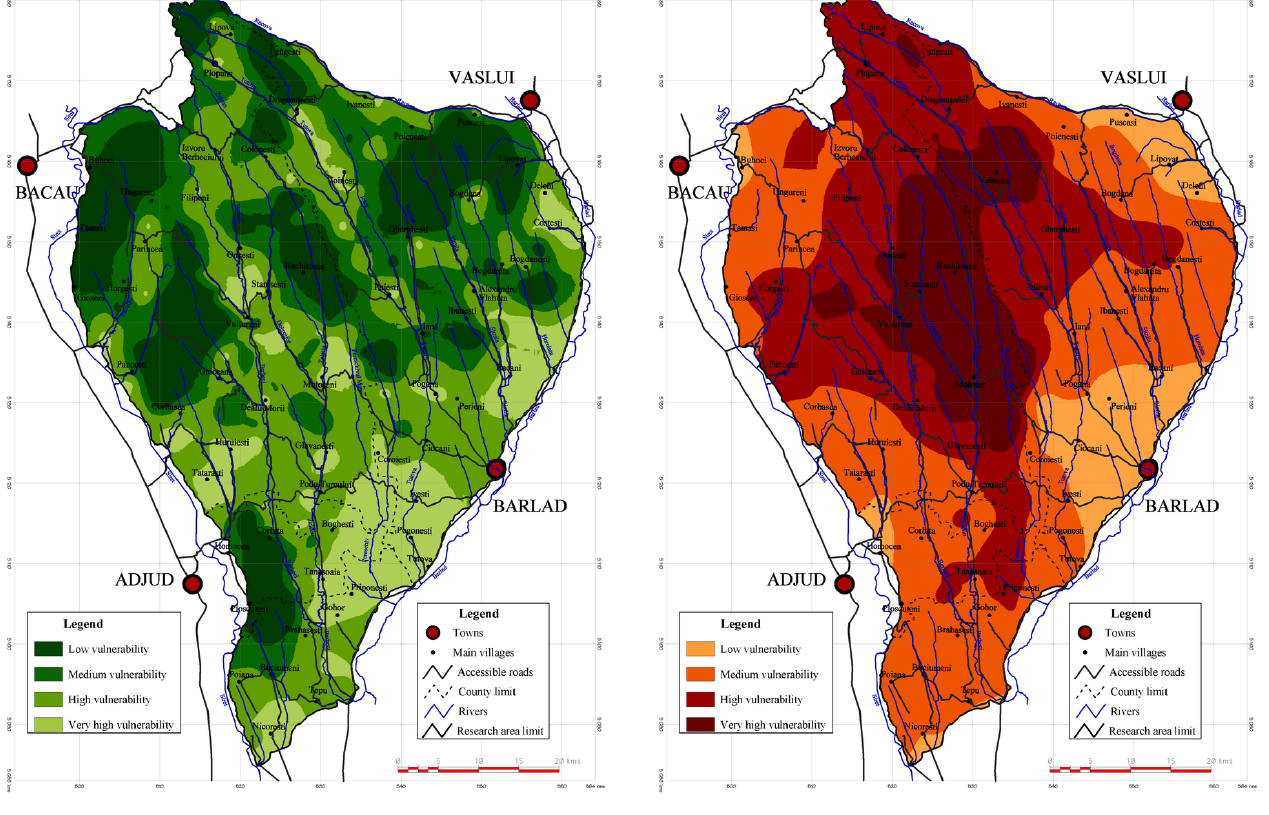
Fig. 6. Vulnerability factor 4: Weight of land under forestry in Tu- tova Hills.